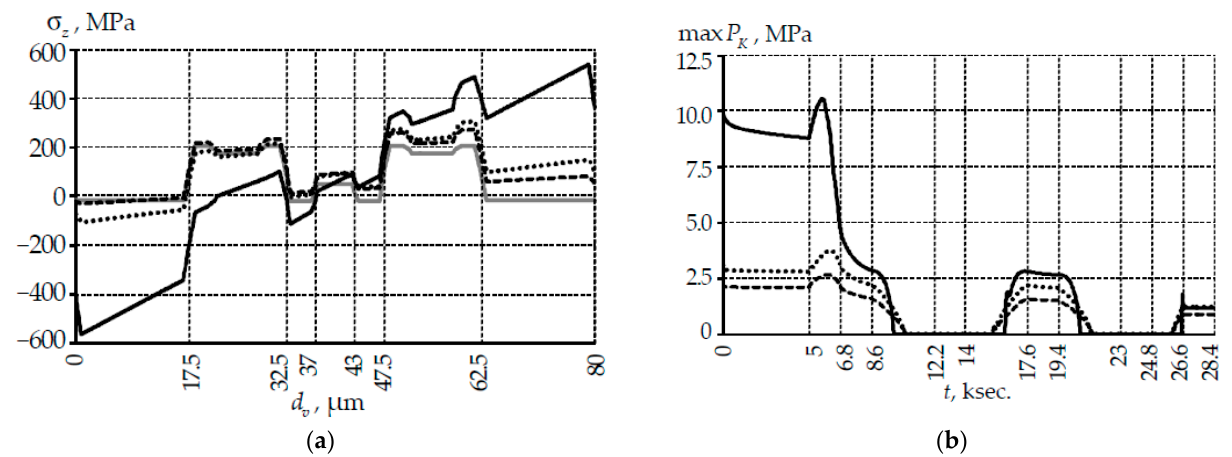
Figure 4. Influence of coil radius and fiber bending on the system deformation parameters: ( a ) is σ z along the fiber central section; ( b ) is max P K ; the gray line is the residual stress after drawing and polarization; black lines are parameters after bending and tension fiber on the coil; solid line is R coil = 5 mm; points is R coil = 22 mm; dotted line is R coil = 50 mm.